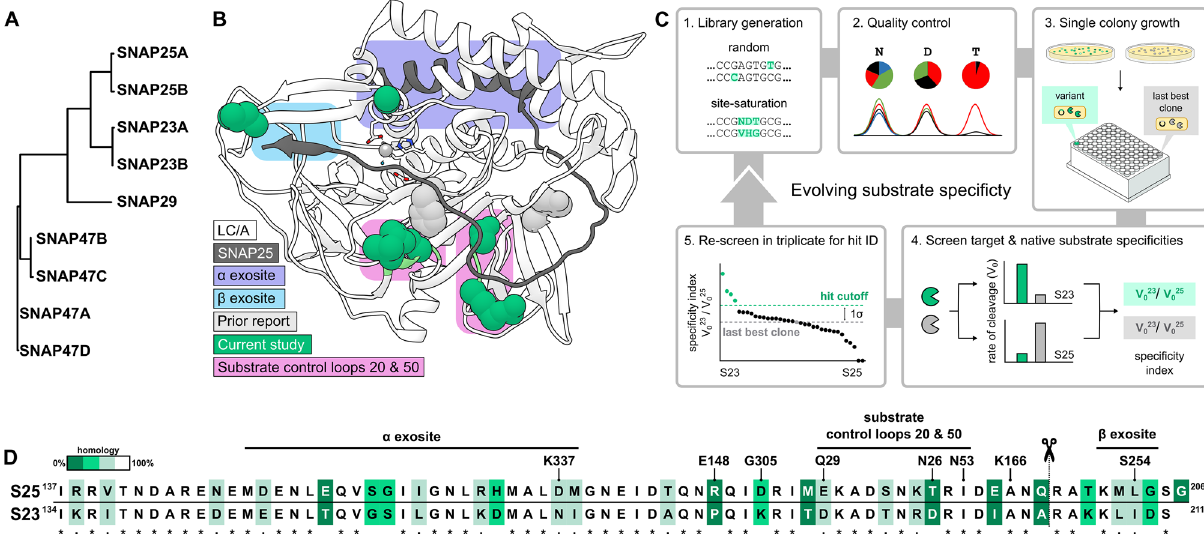
Figure 1. Directed evolution overview. ( A ) SNAP25 sub-family proteins and their isoforms (CLUSTAL 2.1 40 ). ( B ) Co-crystal structure (PDB: 1XTG 27 ) of LC/A (white) and SNAP25 (dark gray). Eight substitutions in LC/A drive SNAP23 specificity (teal) through substrate control loops (pink) alongside prior substitutions (light gray). ( C ) Platform for the directed evolution of SNAP23 substrate specificity. 1. Random or site-directed mutagenesis (e.g., site-saturation); 2. QC by DNA sequencing; 3. High-throughput protein production; 4. Measure V 0 23 and V 0 25 for substrate specificity; 5. Confirmation screens. The most specific and consistent variant from the DARET assay entered the next round of directed evolution. ( D ) Sequence alignment of substrates used for screening (UniProt: P60880, O00161). The SNAP binding exosites in LC/A (residue numbers above) and cleavage site (scissors) are shown. The gradient of color indicates homology from identical (white, *), to strongly similar (light gray, :), weakly similar (teal, .), or dissimilar (dark teal,